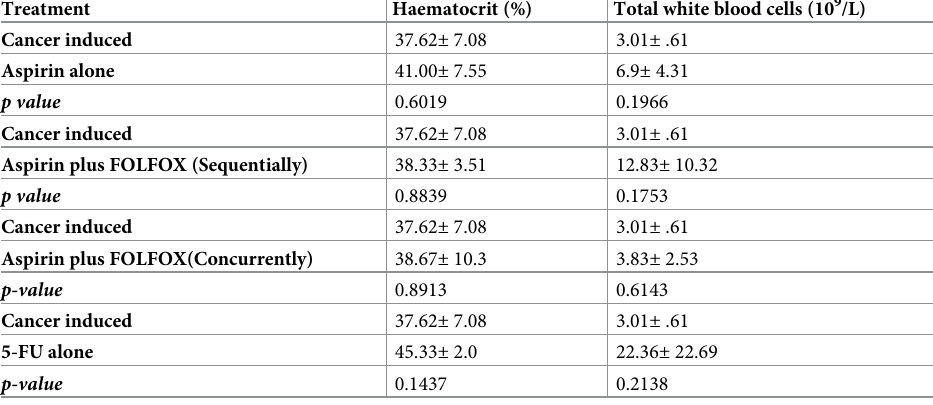
Values are presented as Mean ± SD.